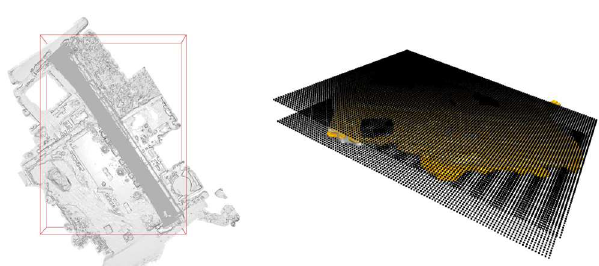
Figure 6: The axis-aligned bounding box of the mesh of one epoch (left) and the grids on top of and under the data